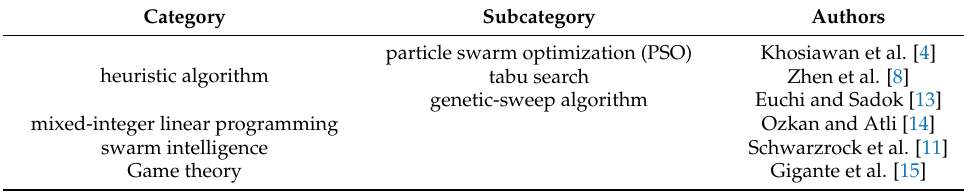
Table 1. Classification of the methods of TSP and